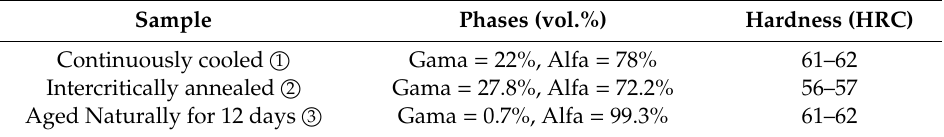
Table 3. Phase fraction of High C-Al KAB steel, “Steel A0” after different heat treatments.